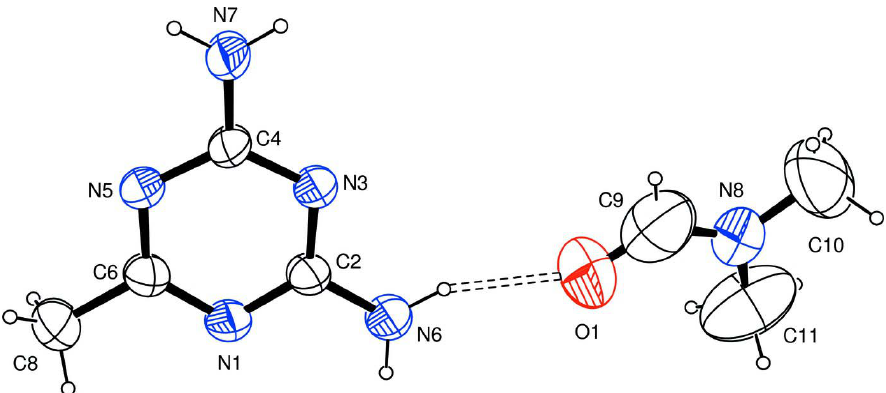
Figure 1 The molecular structure of (I), showing the atom-labelling scheme. Displacements ellipsoids are at the 50% probability